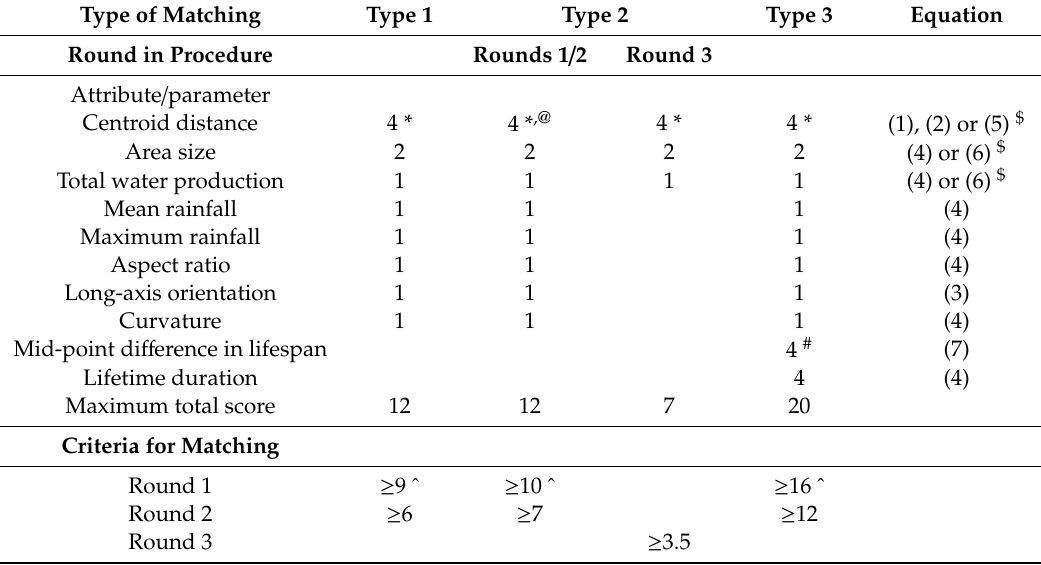
Table 2. Summary of object attributes and parameters selected, their base score (points), maximum total score, equation to compute score, and the criteria used in di ff erent rounds for the three types of matching: between observed and modeled objects at the same time (Section 3.3.1) between objects in successive times in the same dataset (Section 3.3.2) and between observed and modeled mesoscale rainfall systems (MRSs) (Section 3.3.3). Additional requirements are marked by superscripts, with their meaning given at the